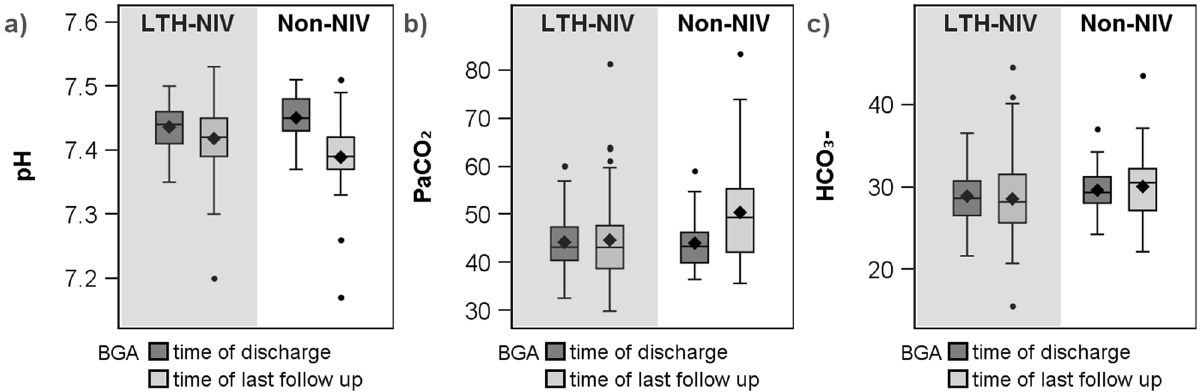
Figure 3. Comparison of pH ( a ), paCO 2 ( b ) and HCO 3 − ( c ) between LTH-NIV patients and Non-NIV patients depending on the time of discharge or last